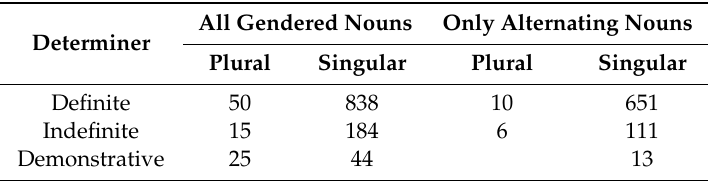
Table 5. Frequencies of determiner types associated with gendered nouns (reported for all gendered nouns and separately for only those that entered into an